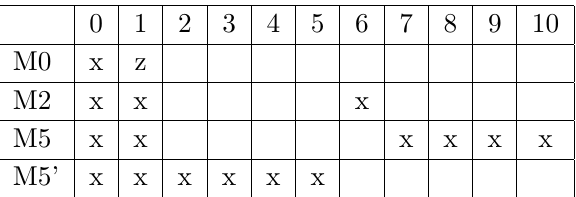
Table 3 . 1 -BPS brane intersection underlying the AdS 3 = Z k (cid:2) S 3 solutions in M-theory. x 1 is 8 the direction of propagation of the wave. ( x 2 ; : : : ; x 5 ) span the CY 2 , x 6 is the direction along the (cid:26) -interval, ( x 7 ; x 8 ; x 9 ; x 10 ) are the transverse directions on which the SO(4) symmetry is realised. The presence of the wave renders the dual CFT